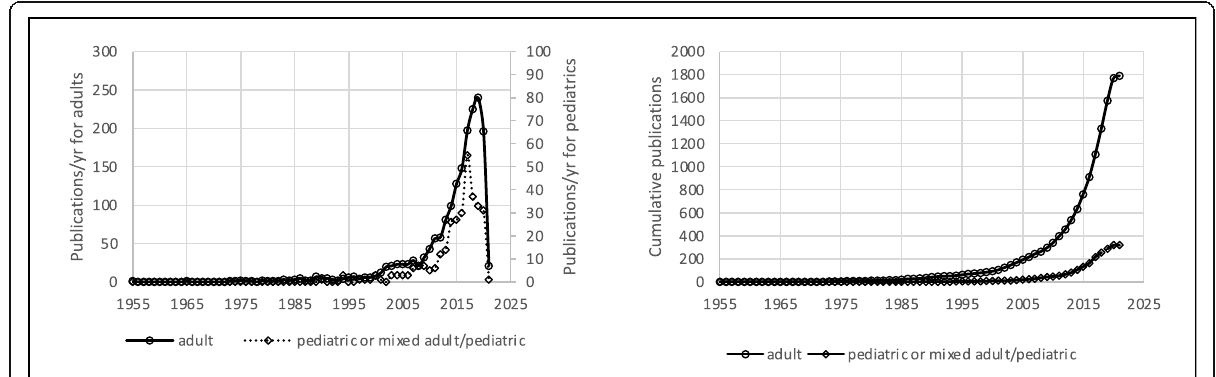
Fig. 4 Number of papers on PND published annually (left) and cumulatively (right) including adult or pediatric-mixed adult/pediatric surgical patients